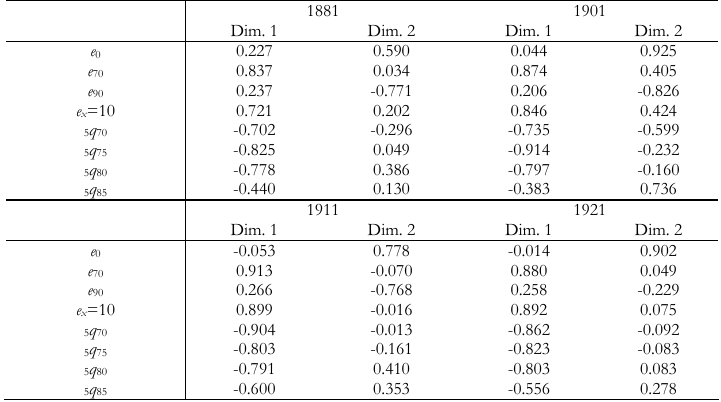
Correlations of the original variables with the first two dimensions of the compromise 1881 1901 Dim.